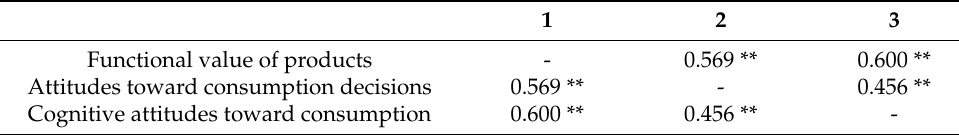
Table 8. Matrix of green design and consumption value and behaviors ( N = 324). 1 2 3 Functional value of